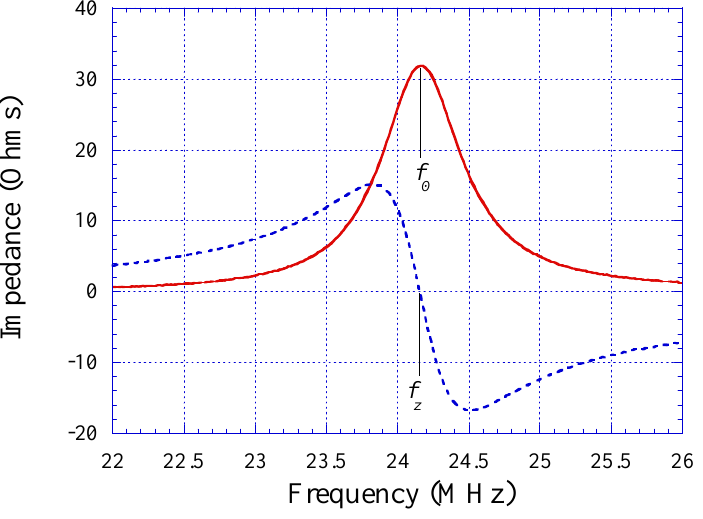
Fig. 3. The real and imaginary portions of the impedance spectrum of the sensor after the background subtraction. The resonant frequency f impedance, while the zero-reactance frequency f